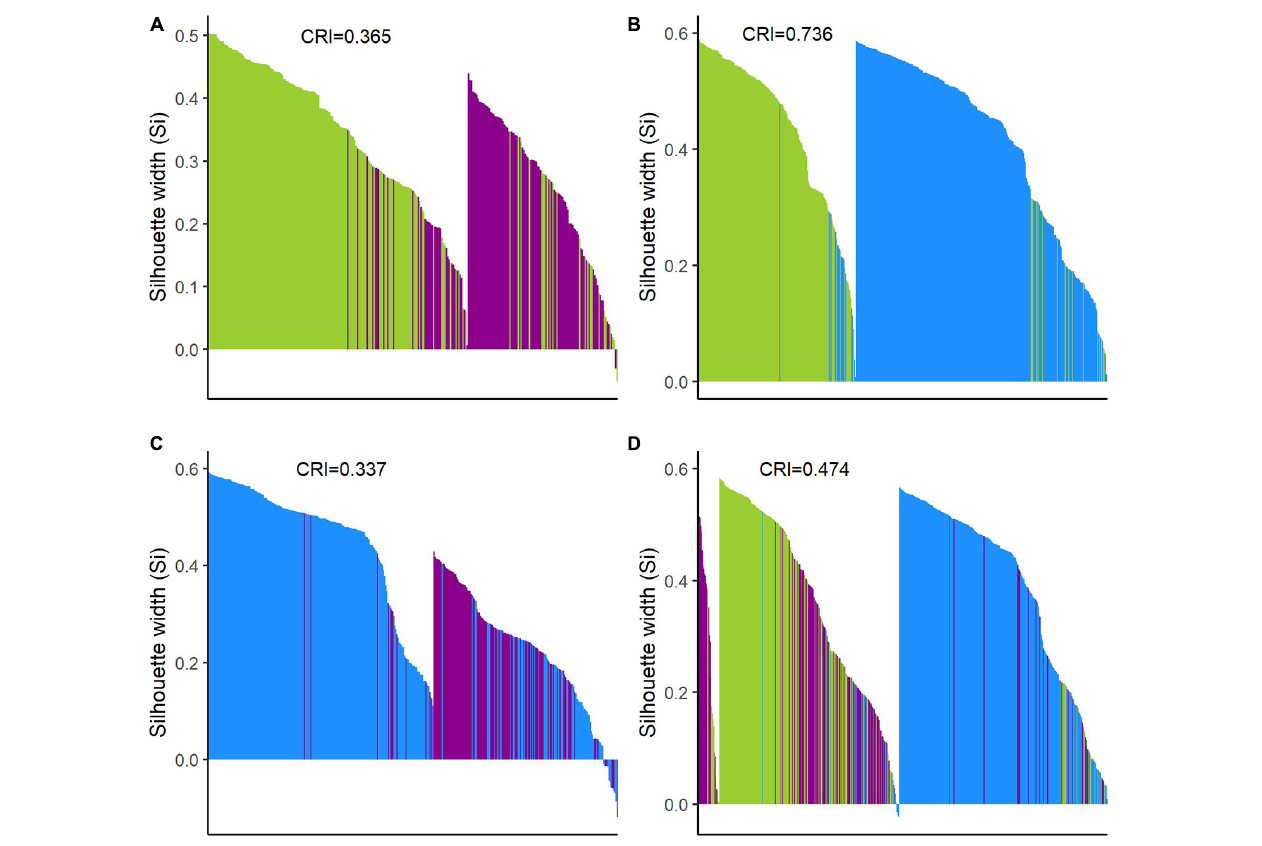
FIGURE 6 | Silhouette plots of k -means clustering analyses. Plots show the Silhouette coefficient (Si) of each observation (bar). Si close to 1: objects are very well clustered; Si close to 0: objects lie between two clusters; and negative Si: objects are probably placed in the wrong cluster. (A) Wild and feral; (B) wild and domesticated; (C) feral and domesticated; and (D) the three cotton groups. Wild = green, feral = magenta, and domesticated =